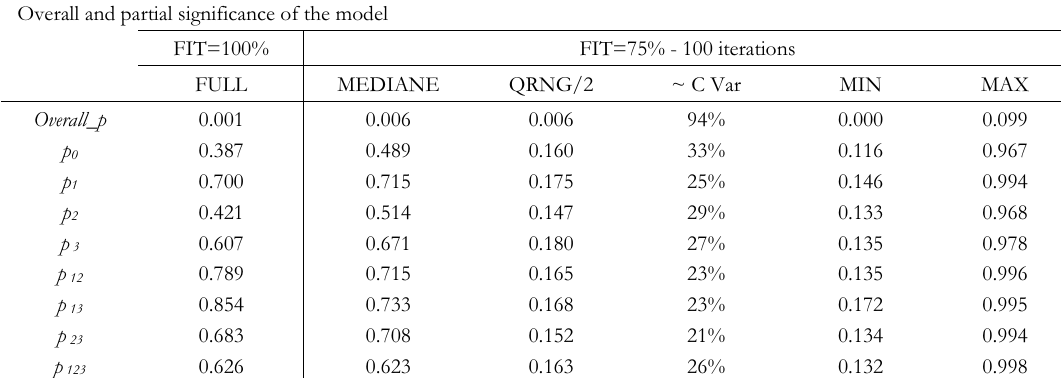
Quality of the model’s fit: significance Overall and partial significance of the